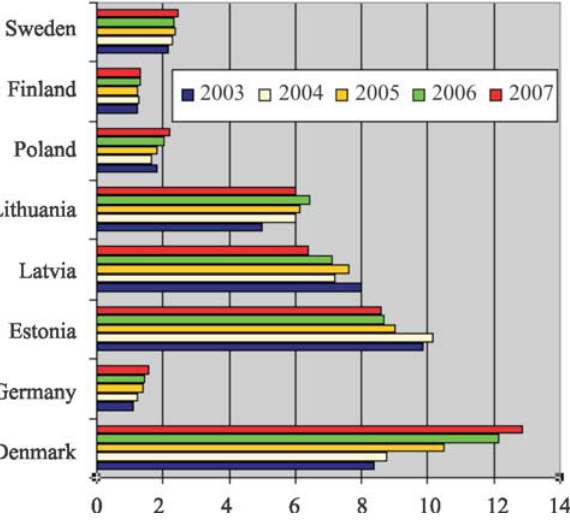
Fig. 6 . Th e dynamics of transport services in BSR, mill. EUR (source: